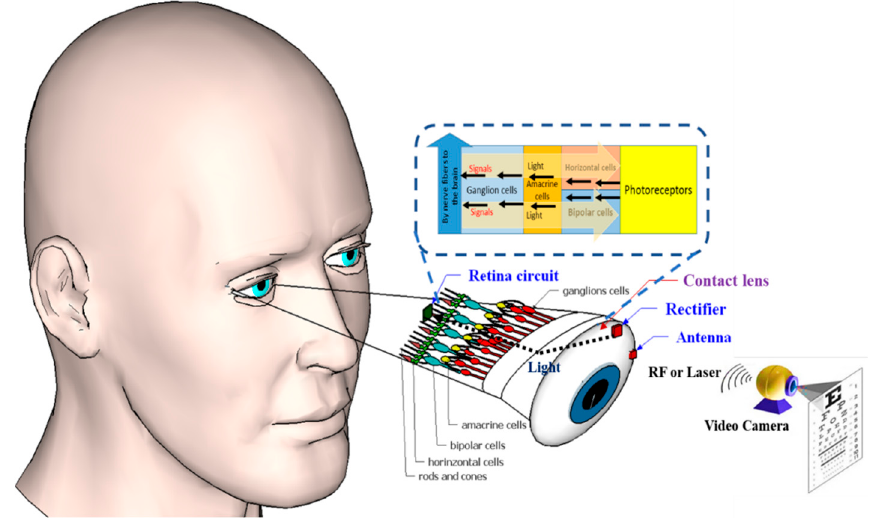
Figure 1. A conceptual layout at the interface between wireless power devices and complementary metal oxide semiconductor (CMOS) retina neuron integrated circuit (IC) for image acquisition.